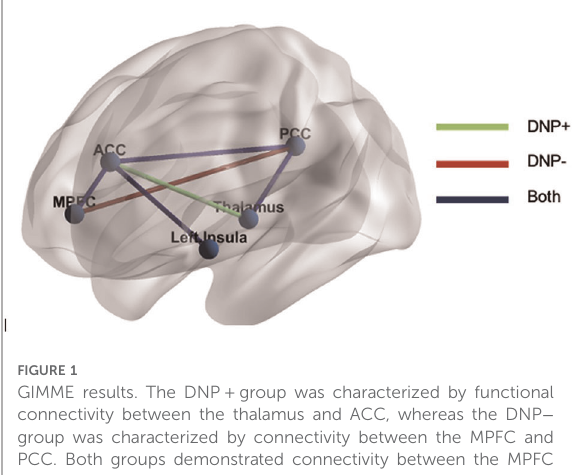
FIGURE 1 GIMME results. The DNP+group was characterized by functional connectivity between the thalamus and ACC, whereas the DNP − group was characterized by connectivity between the MPFC and PCC. Both groups demonstrated connectivity between the MPFC and ACC, ACC and PCC, ACC and insula, and PCC and thalamus. Note: MPFC, medial prefrontal cortex; ACC, anterior cingulate cortex; PCC, posterior cingulate cortex.